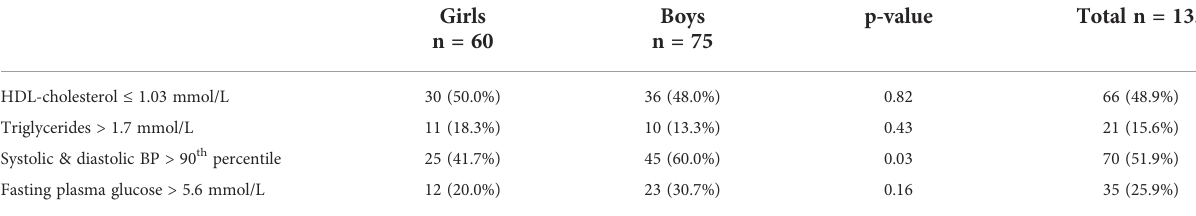
TABLE 2 Distribution of cardiometabolic risk factors among MUO children by